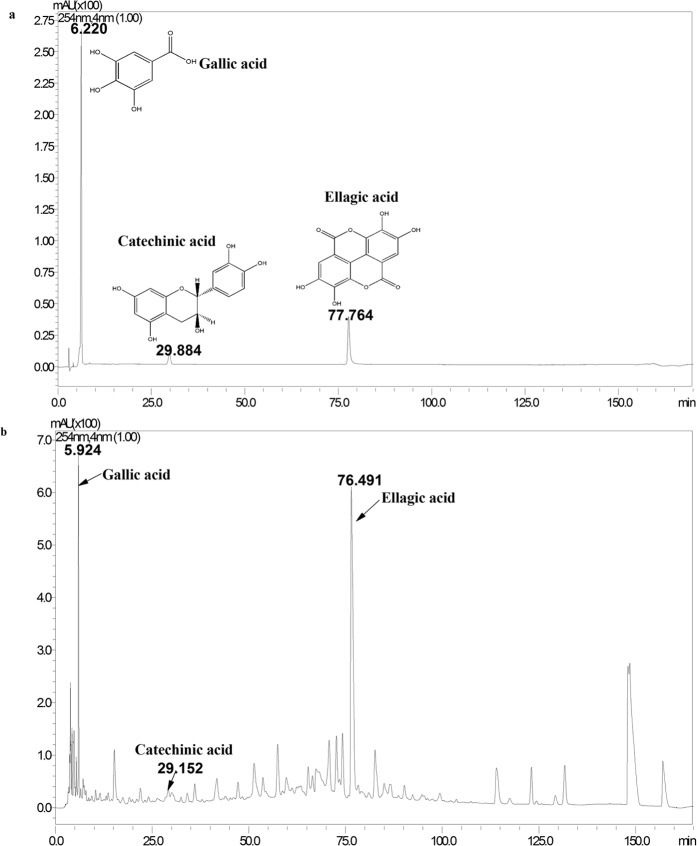
HPLC chromatograms of water extract of DY and its three tannins.(a) HPLC chromatograms of three tannins in DY (GA, CA and EA). (b) HPLC chromatograms of the overall extract of DY.